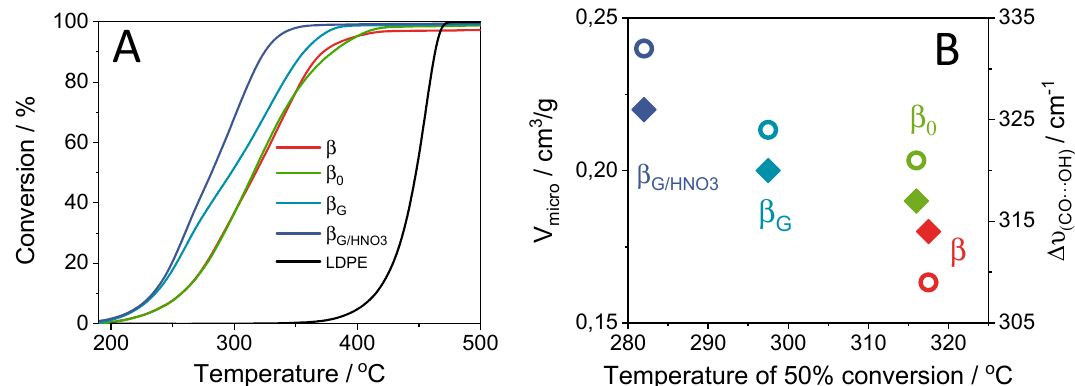
Figure 4. ( A ) Conversion curves of low-density polyethylene (LDPE) cracking on studied zeolites. The thermal cracking of LDPE is included for comparison. ( B ) The correlation between catalytic activity in polyethylene decomposition (temperature for 50% conversion) and the strength of sites (open symbols) and V micro (solid